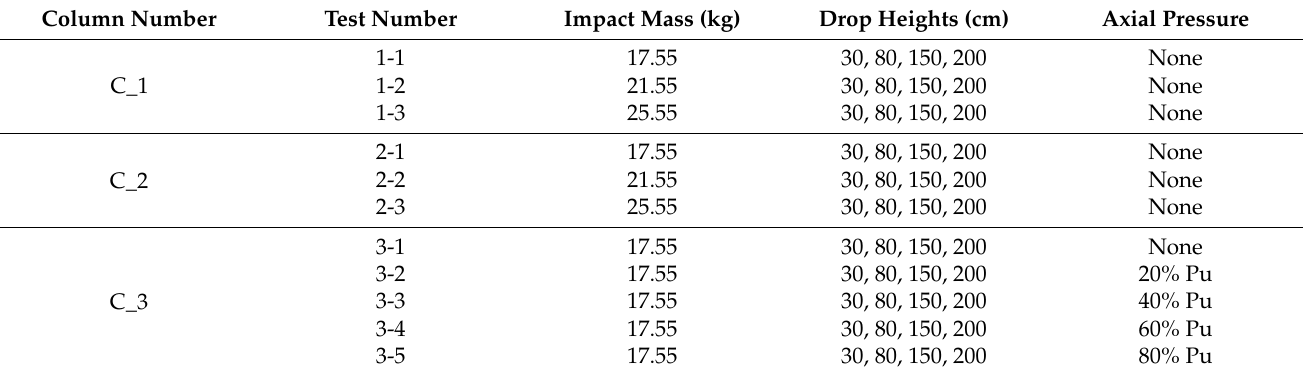
Table 1. Lateral impact experimental